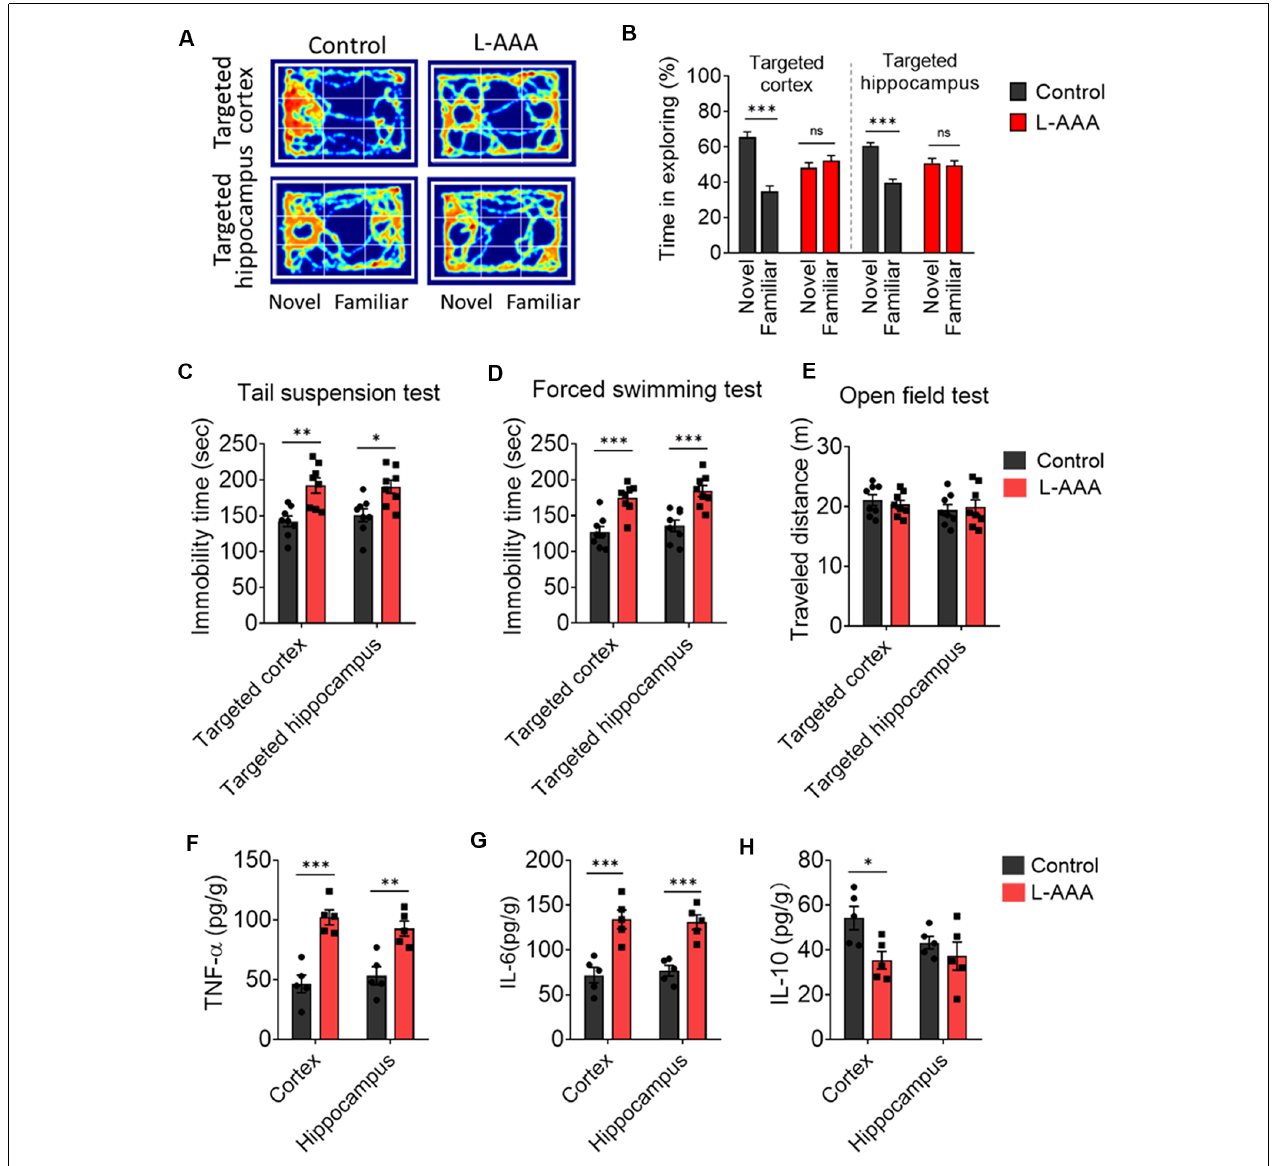
FIGURE 3 | Ablation of astrocytes results in depressive-like behaviors, cognitive impairs, and neuroinflammation. (A,B) The novel object recognition test was used to evaluate cognitive function. Results in panels (B) reflect the results of 8–9 mice per group. Data are mean ± SEM. ∗∗∗ p < 0.005; unpaired t -test. (C–E) Depressive-like behaviors were measured in the (C) tail suspension test, (D) forced swimming test, (E) open-field test. Results in panels (C–E) reflect the results of eight mice per group. (F–H) Protein expression of inflammatory cytokines (TNF- α , IL-6, and IL-10) in the cortex and hippocampus. Results in panels (F–H) reflect the results of five mice per group. Data are mean ± SEM. ∗ p < 0.05, ∗∗ p < 0.01, ∗∗∗ p < 0.005; two-way ANOVA. ns: not significant ( p >